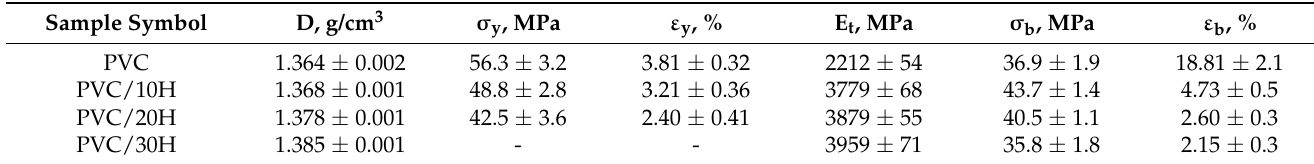
Table 6. Results of density and mechanical properties of PVC and PVC composites with addition of hop residue after extraction.